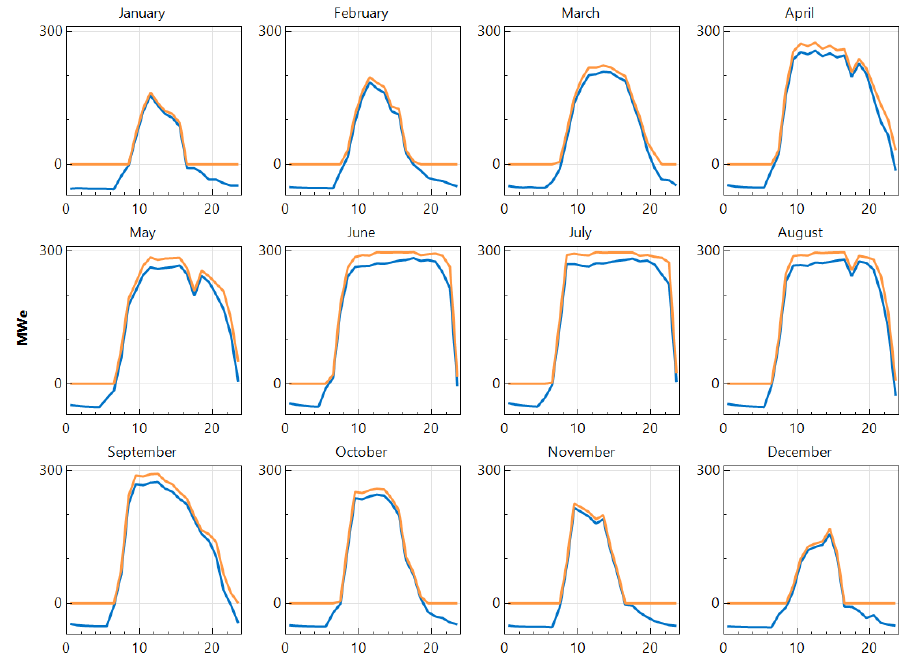
Figure 10. Solana power plant in Amman with SAM monthly average daily operation over a year. X is the time of the day, Y the power gross and net at the turbines. Orange lines refer to gross while the blue ones refer to the net.